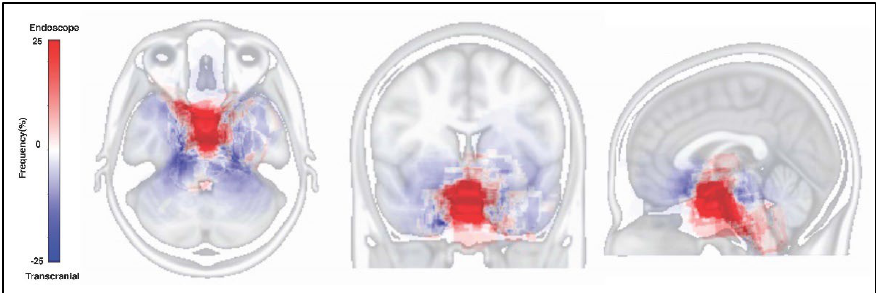
Figure 2. Tumor resected map on the Montreal Neurological Institute 152 standard brain atlas. The red area indicates the frequently resected area by endonasal endoscopic approach. The blue area indicates the frequently resected area by transcranial approach.